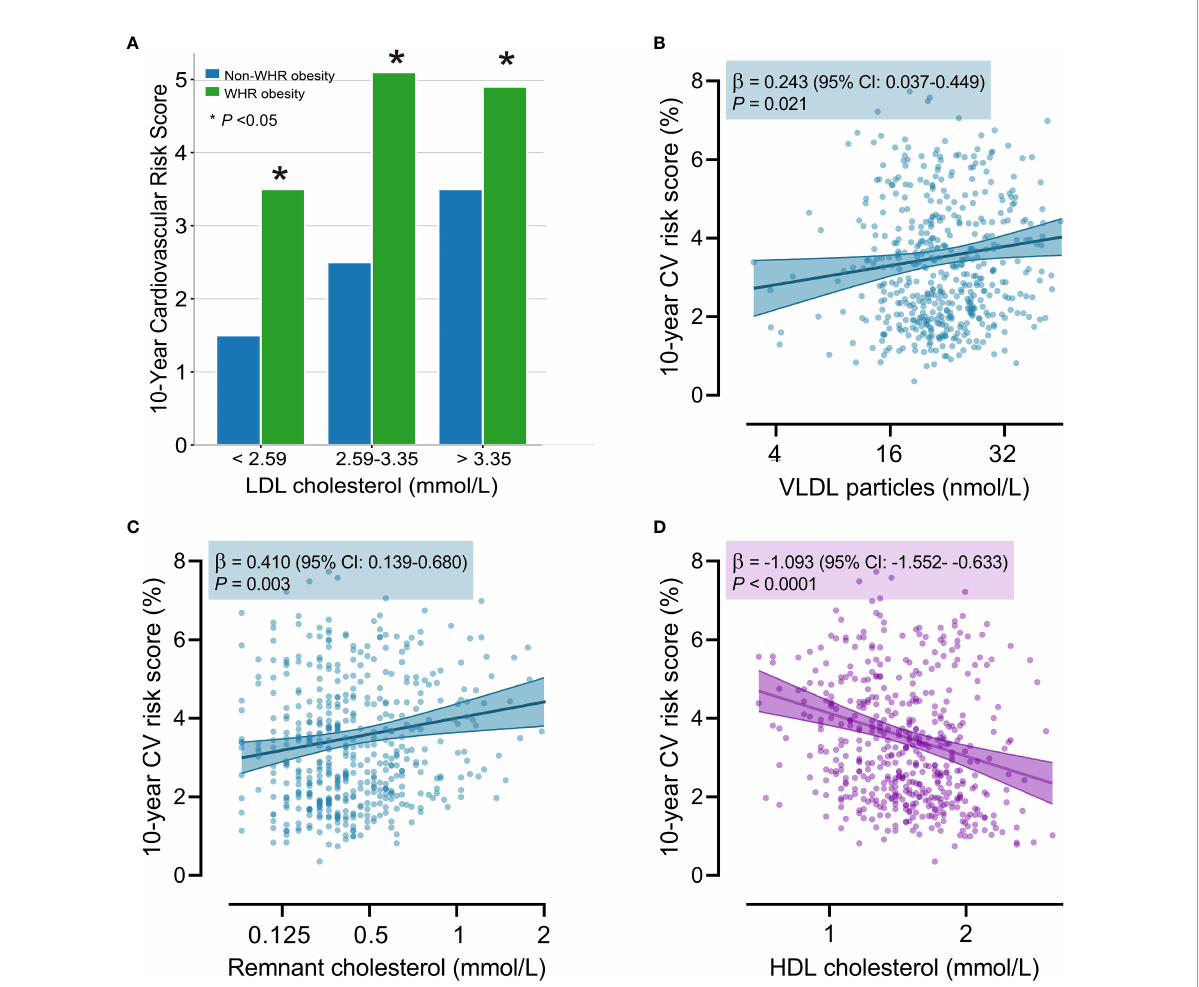
FIGURE 2 The relationship between 10-years cardiovascular risk score, WHR obesity, and lipid parameters. (A) The 10-years cardiovascular risk score across the LDL cholesterol categories and WHR obesity categories. The star (*) indicated a P-value < 0.05 between two groups in the same LDL cholesterol category. The linear association of cardiovascular risk with total VLDL particle concentration (B) , remnant cholesterol (C) , and HDL cholesterol (D) . The linear association was adjusted for sex and age. The solid line represents the regression line. The band with two solid lines indicates the 95% con fi dence limits of the regression line, and the transparent band refers to the 95% prediction limits of the regression model. b coef fi cients were calculated for a doubling of the lipid concentration. The 10-years cardiovascular risk score was estimated by the SCORE2 algorithm. HDL, high-density lipoprotein; LDL, low-density lipoprotein; VLDL, very-low-density lipoprotein; WHR, waist-to-hip